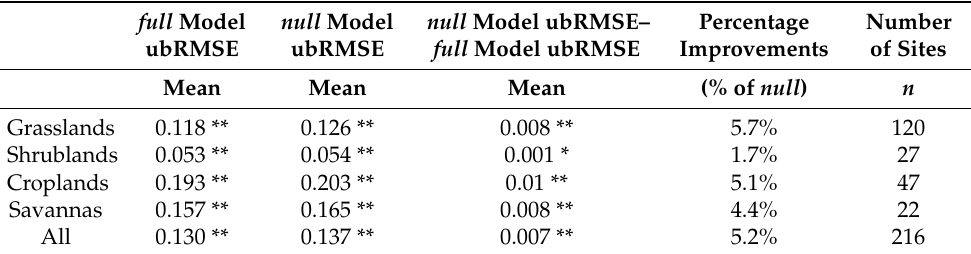
Table 2. Statistics of “ null ” model ubRMSE and “ full ” model ubRMSE for LAI anomaly predictions and the statistics of the difference in ubRMSE between the “ full ” models and “ null ” models and for the LAI anomaly predictions or LAI predictions (asterisks indicate the ubRMSE of the models are significantly greater than 0 with different significant levels * 0.05; ** 0.01. Note: This table is the same for LAI predictions due to how we reconstruct LAI using the “ full ” model and “ null ” model predicted LAI anomalies combined with static LAI climatology). full Model